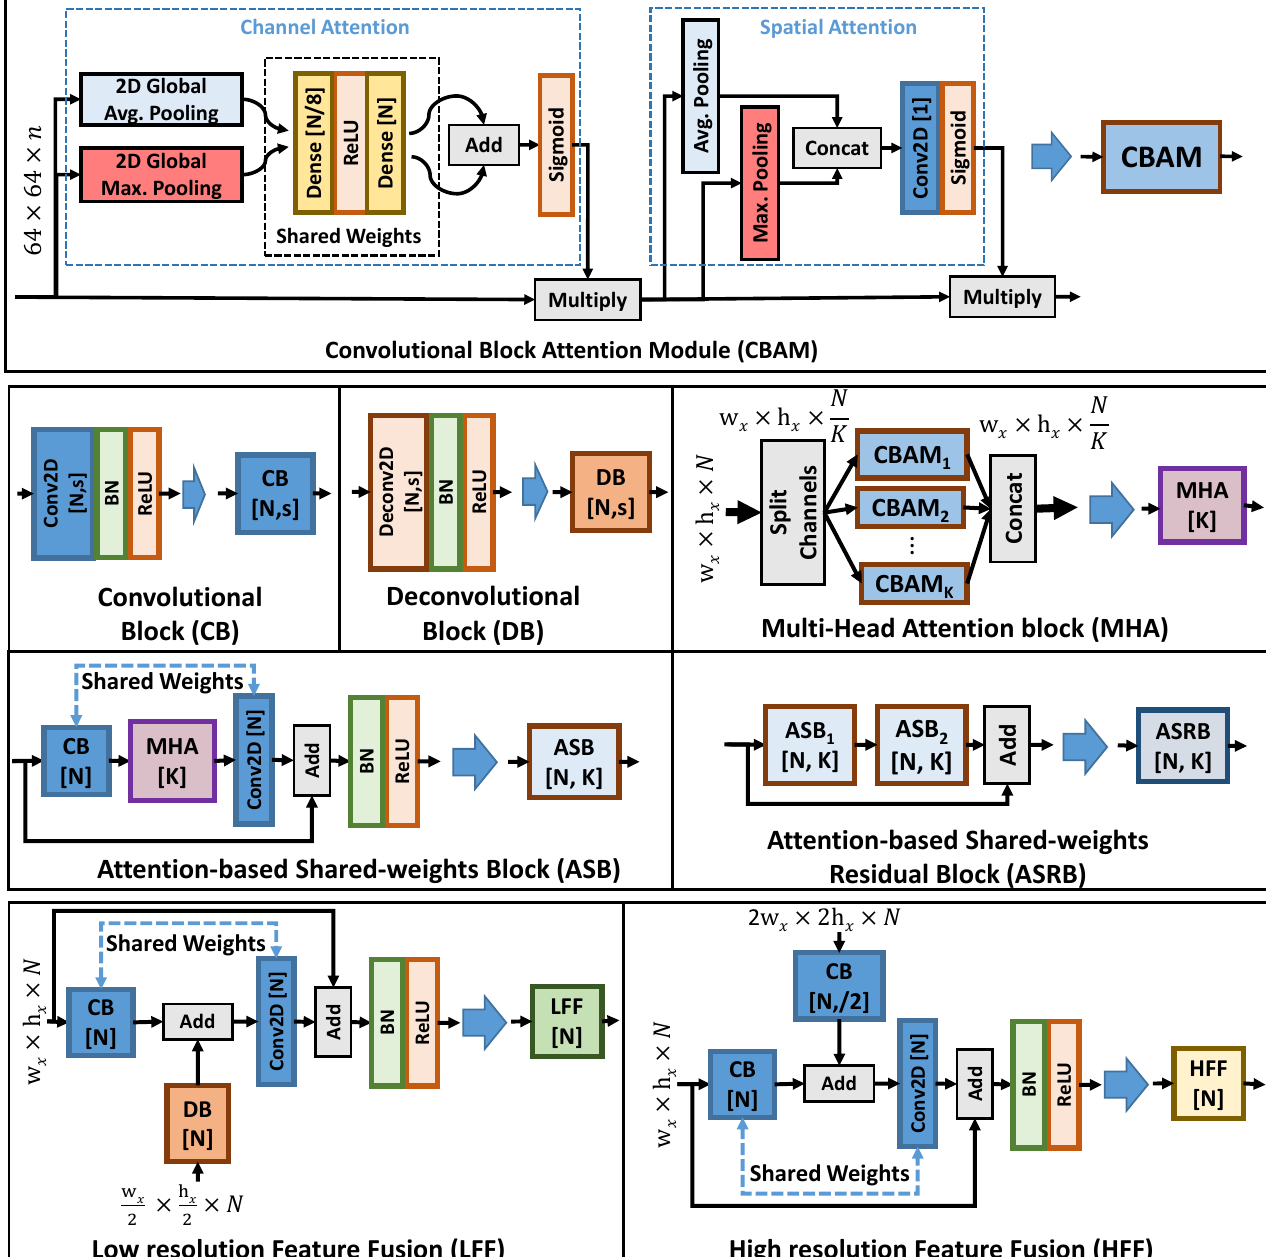
Figure 3. The layer structure of the eight types of blocks used to build ASQE-CNN. ( Top ) The attention mechanism implemented using the convolutional block attention module (CBAM) proposed in [44]. ( Middle ) Simple building blocks (convolutional and deconvolutional blocks) and novel attention-based blocks with weight sharing. ( Bottom ) Novel multiresolution feature fusion blocks: ( left ) low-resolution feature fusion (LFF), ( right ) high-resolution feature fusion